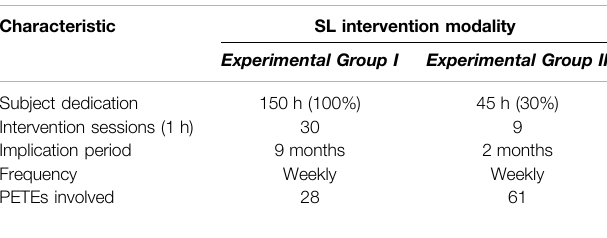
TABLE 1 | Dedication characteristics of the SL